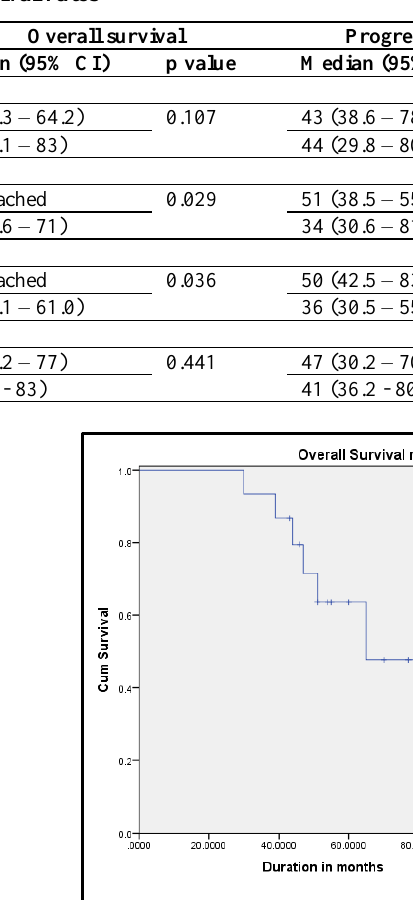
Figure 2: Overall survival curve of 15 pediatric patients with fourth ventricle